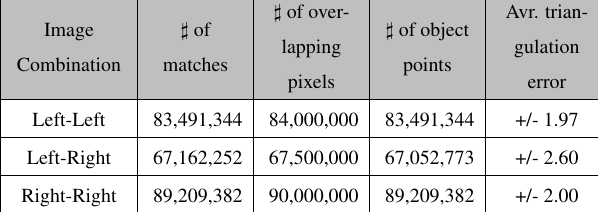
Table 1: Statistical summary of the image matching results.